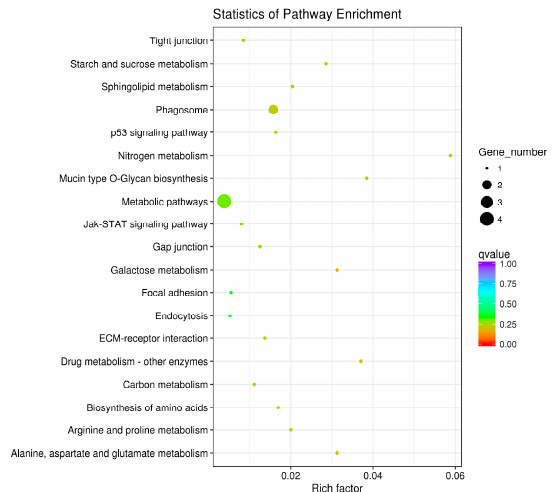
Figure 7. KEGG (Kyoto Encyclopedia of Genes and Genomes) Analyses of the hypothalamic DEGs. The vertical axis represents the pathway name, the horizontal axis represents rich factor, the size of the point represents the number of differentially expressed genes in this pathway, and the color of the point corresponds to different Q-value ranges (the same below).